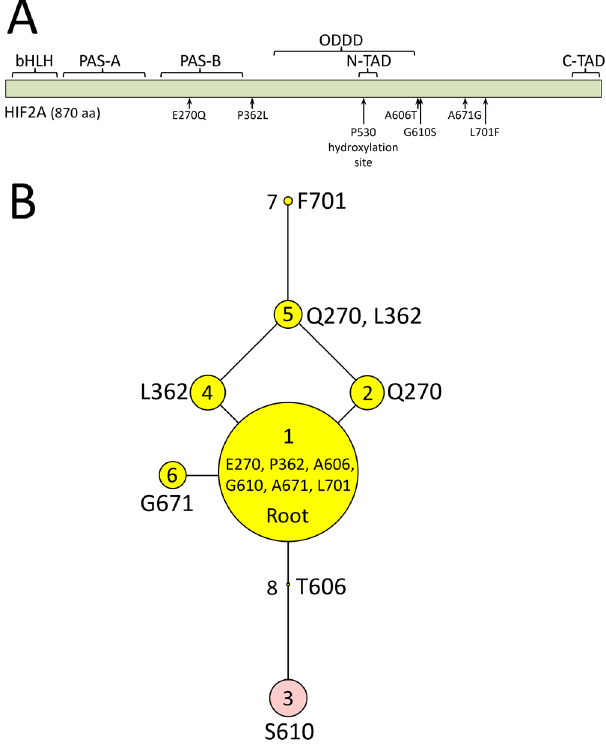
Figure 3. Physical map and rooted maximum parsimony phylogenetic tree of HIF2 α protein variants ( EPAS1 haplotypes). Panel A , map of bovine HIF2 α domains in relationship to missense mutations found in cattle: bHLH, basic helix-loop-helix domain; PAS-A and PAS-B, Per-Arnt-Sim domains; ODDD, oxygen- dependent degradation domain; N-TAD, N-terminal transactivation domain; C-TAD, C-terminal transactivation domain. Panel B , HIF2 α polypeptide sequences encoded by haplotype variants. The areas of the circles are proportional to the variant frequency in a group of 1,250 cattle from 46 breeds with each node in the tree representing a different polypeptide sequence of HIF2 α that varies by one amino acid compared to adjacent nodes. Reproduced from Heaton et al. , 2016 9 . Table 2. EPAS1 haplotype frequencies among cases and controls. Allele frequencies Haplotype Distinguishing code